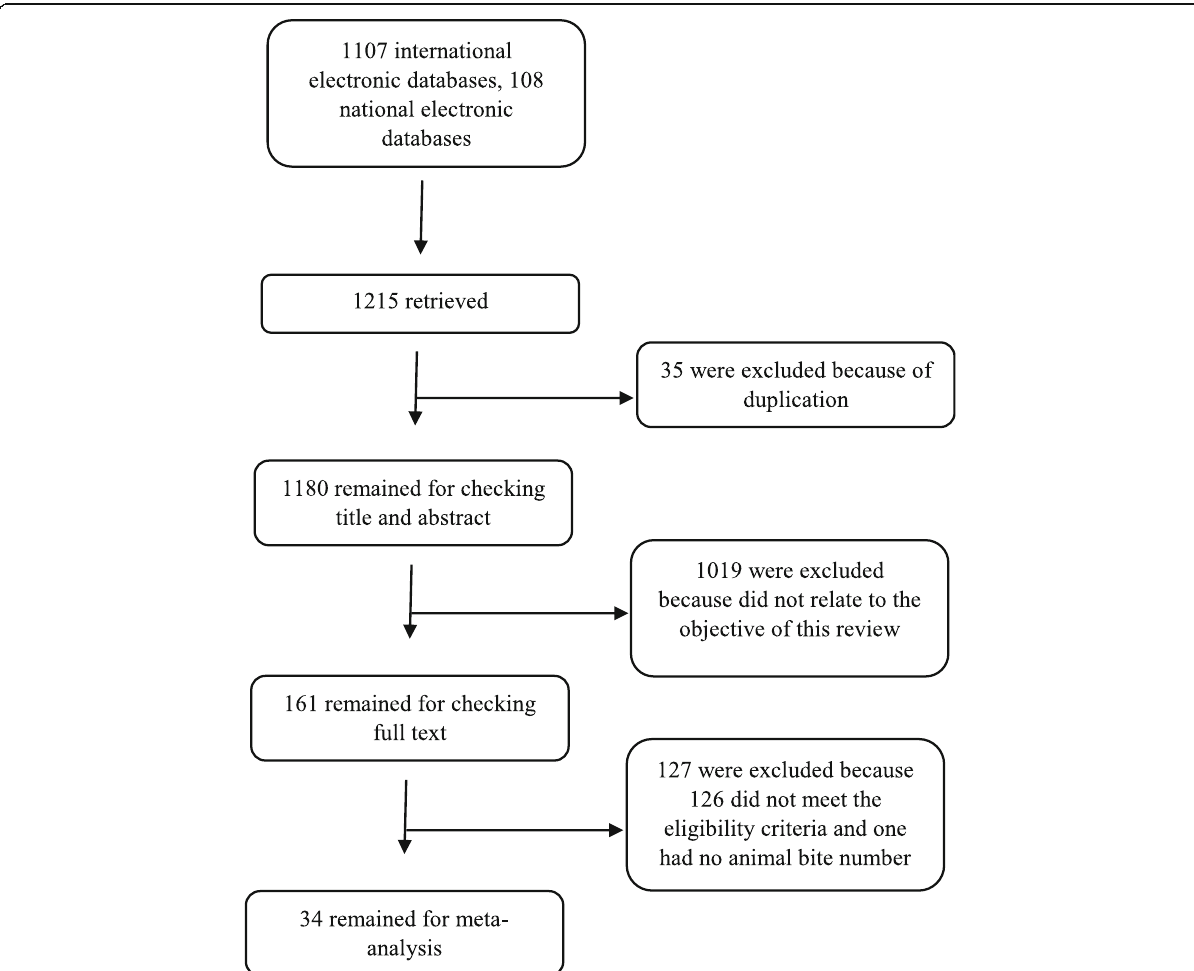
Fig. 1 Total number of retrieved studies, deletion procedure of non-related studies and number of remain articles for